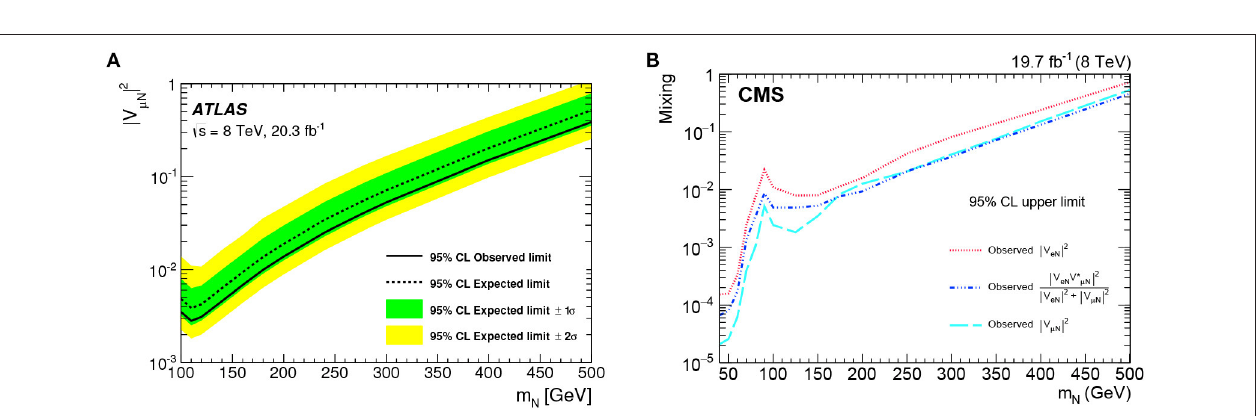
FIGURE 9 | At 14 TeV and as a function of M N , (A) the 2 σ sensitivity to S (dash-star) discovery in the same channel (C,D) Same as (A,B) but for 100 TeV [254].